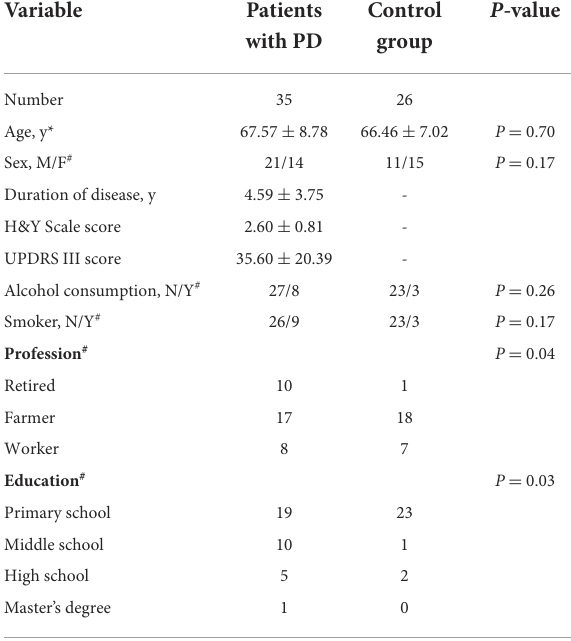
TABLE 1 Baseline characteristics of the